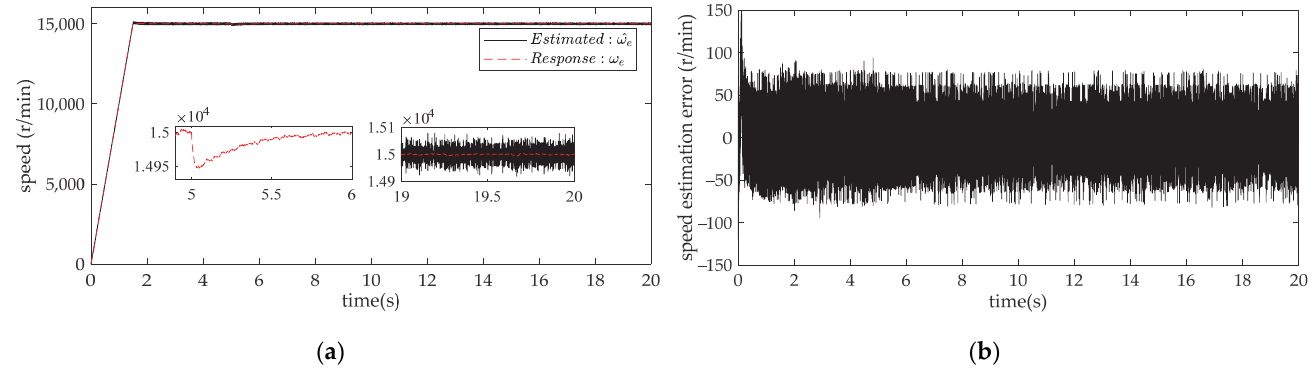
Figure 4. ( a ) Speed estimation of the traditional sliding mode observer; ( b ) Estimation error.